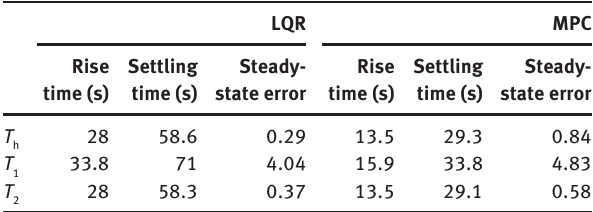
Table 2 Nip point temperature responses in LQR and constrained MPC.